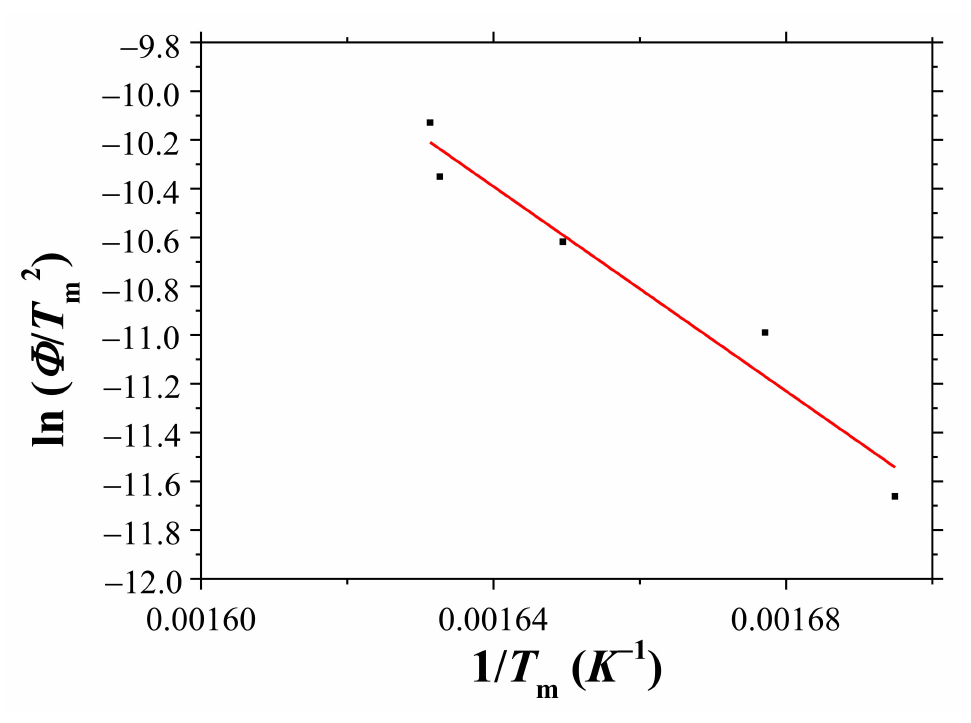
Figure 9. Plot of ln ( Φ / T m2 ) versus 1/ T m